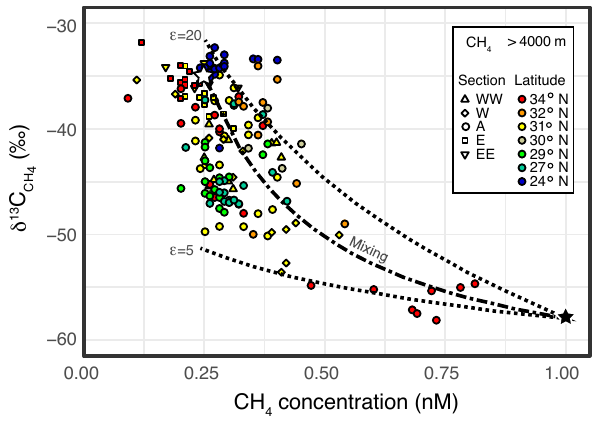
Figure 6. A plot between CH 4 concentration and δ 13 C CH ored symbols are same as those in Fig. 2. Open and filled stars, re- spectively, represent end-member values assumed for background seawater and inner-trench CH 4 sources. Dashed curves represent theoretical isotope behaviors from the local CH 4 source when ki- netic isotope effects on microbial methanotrophy ( ε) are 5 and 20. A dash–dotted curve represents a bimodal mixing between two end-